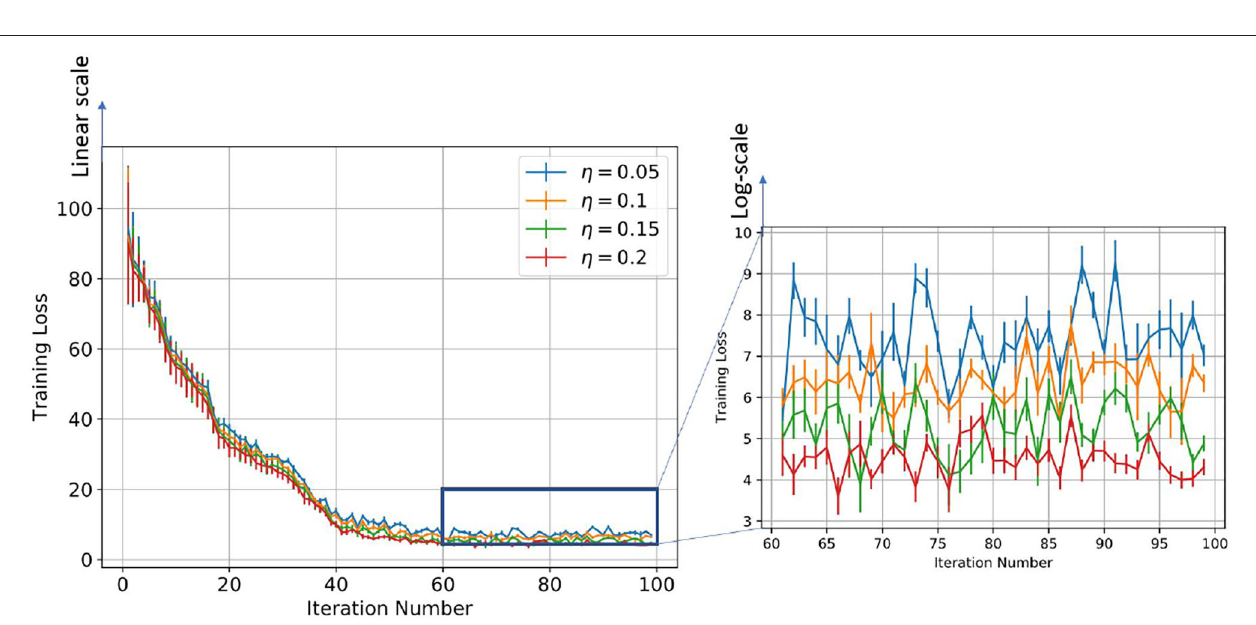
FIGURE 8 | Figure showing the change in training loss with iterations for varying learning rates for the log-STDP learning process.